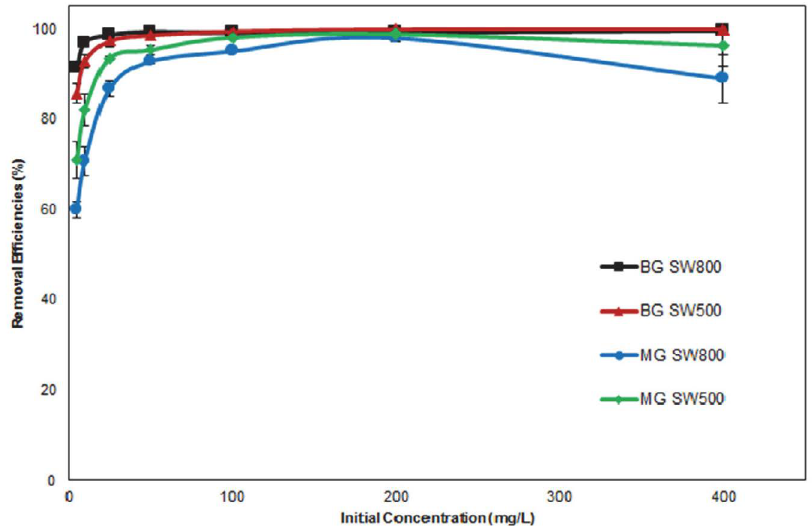
Figure 7. Effect of initial concentration on the removal of BG and MG (adsorbent dose of BG and MG: 0.4 and 0.6 g/L for SW800 and, 1.2 and 2.4 g/L for SW500, initial dye concentration range 5–400 mg/L, volume 25 mL, contact time 24 h, n =